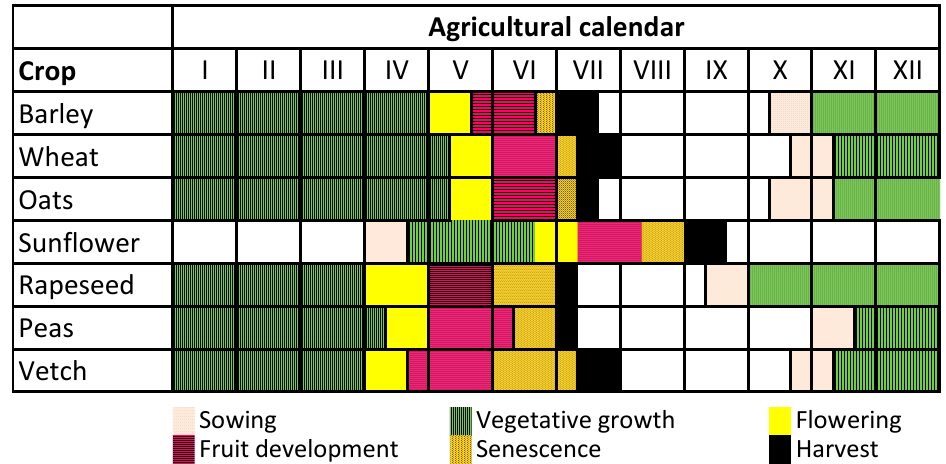
Figure 3. Agricultural calendar of the crops cultivated in the area. Sowing and harvest dates are shown, as well as main phenological stages (their duration is approximate).